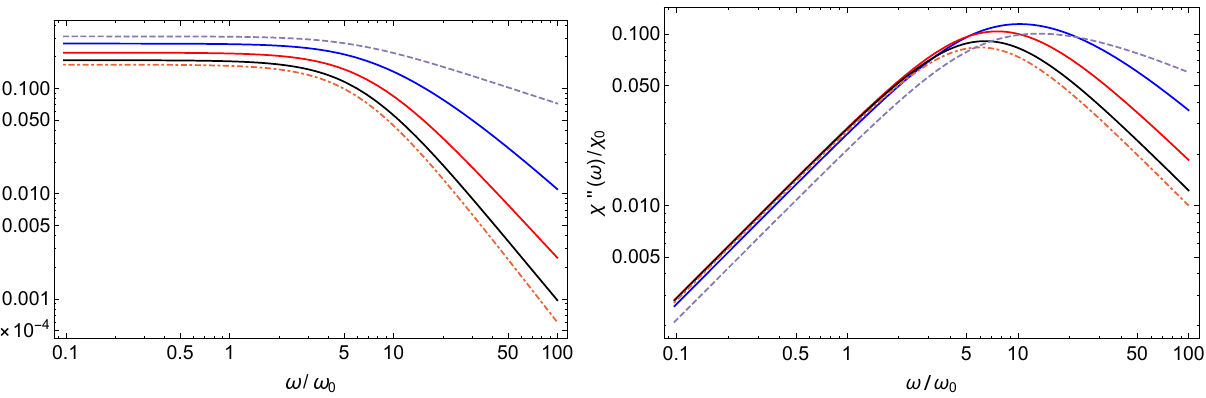
Figure 9. Behaviour of the complex susceptibility (log–log plot) for combined Debye and Cole– Cole relaxation with resetting parameter r = 5. The dot-dashed lines stand for pure Debye with resetting, the dashed lines represent pure Cole–Cole with resetting, while the black, red, and blue lines correspond to a 1 = 0.8, a 2 = 0.2, a 1 = 0.5, a 2 = 0.5, and a 1 = 0.2, a 2 = 0.8, respectively. Left panel : real part. Right panel : imaginary part (dielectric